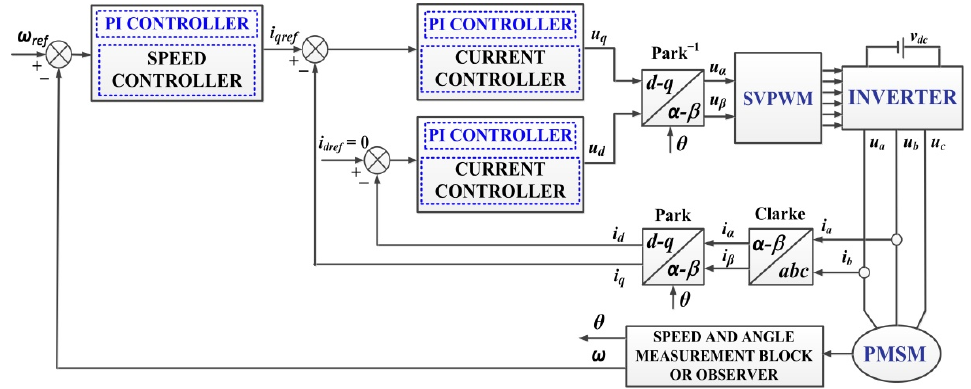
Figure 1. General block diagram for PMSM control system based on FOC-type strategy.